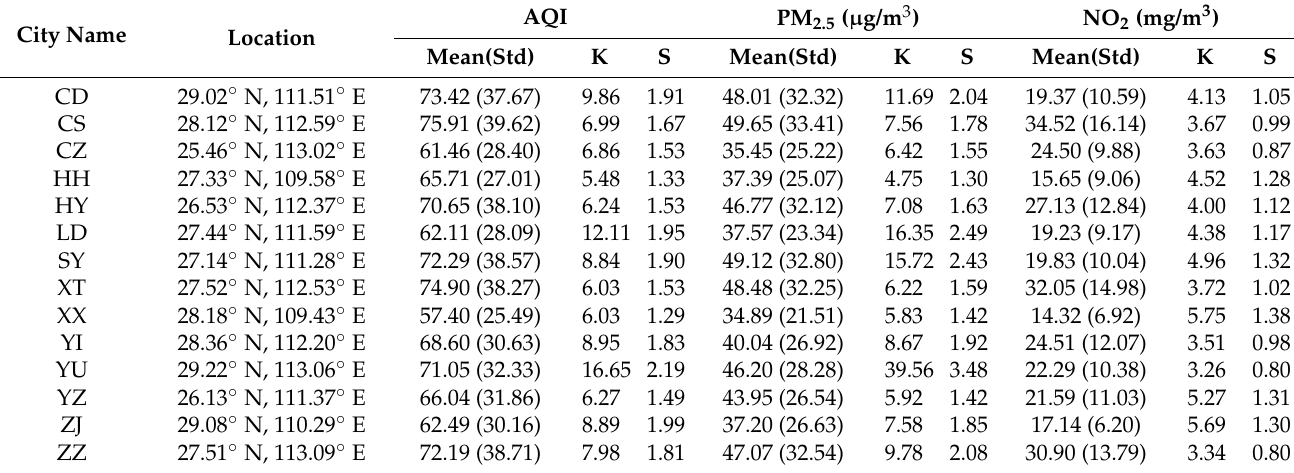
Table 1. Descriptive statistics of AQI, PM 2.5, and NO 2 of 14 cities of Hunan